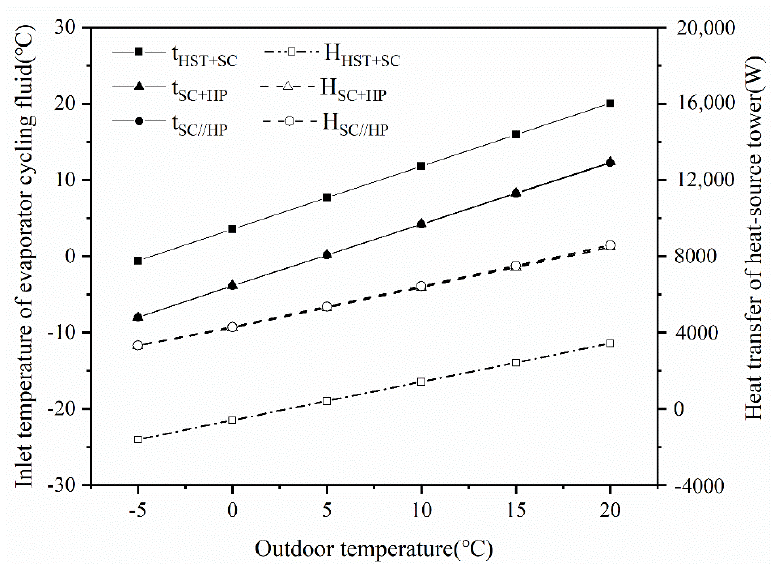
Figure 8. The change in the circulating fluid’s temperature of heat pump’s inlet and the heat transfer of heat-source tower with the outdoor temperature ( I = 500 W/m 2 ).